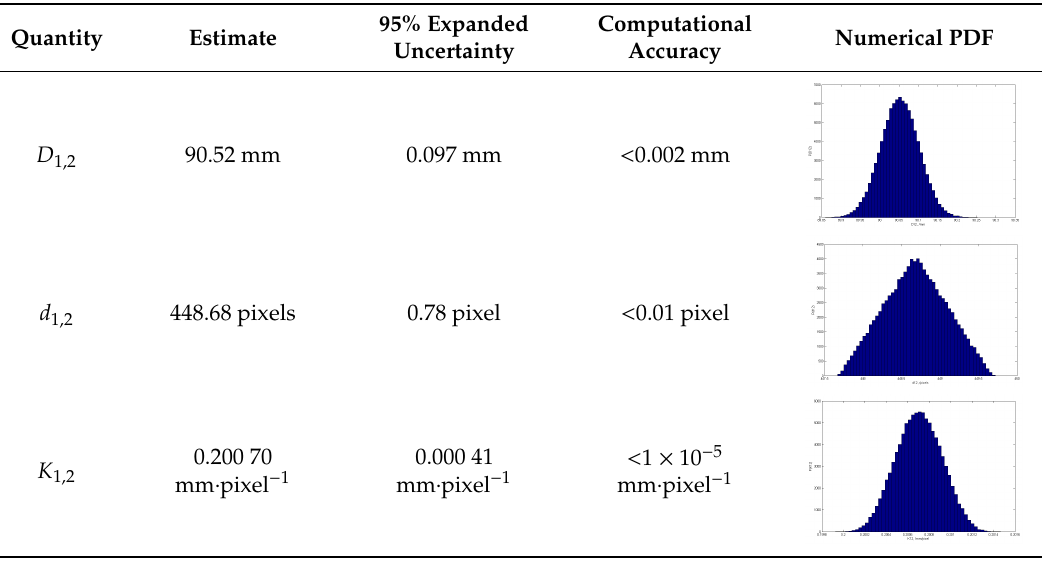
Table 6. Results of the MCM simulation for the determination of the measurement uncertainty of scale coefficient K 1,2 obtained with referential B. PDF: probability density functions.